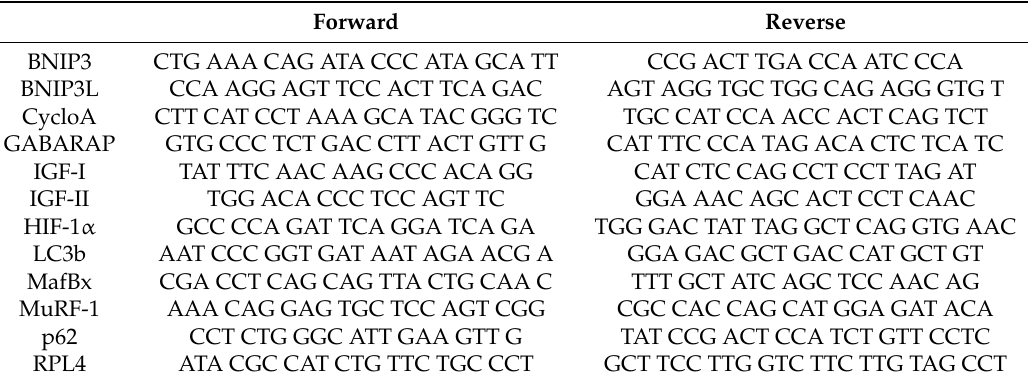
Table 2. Primers